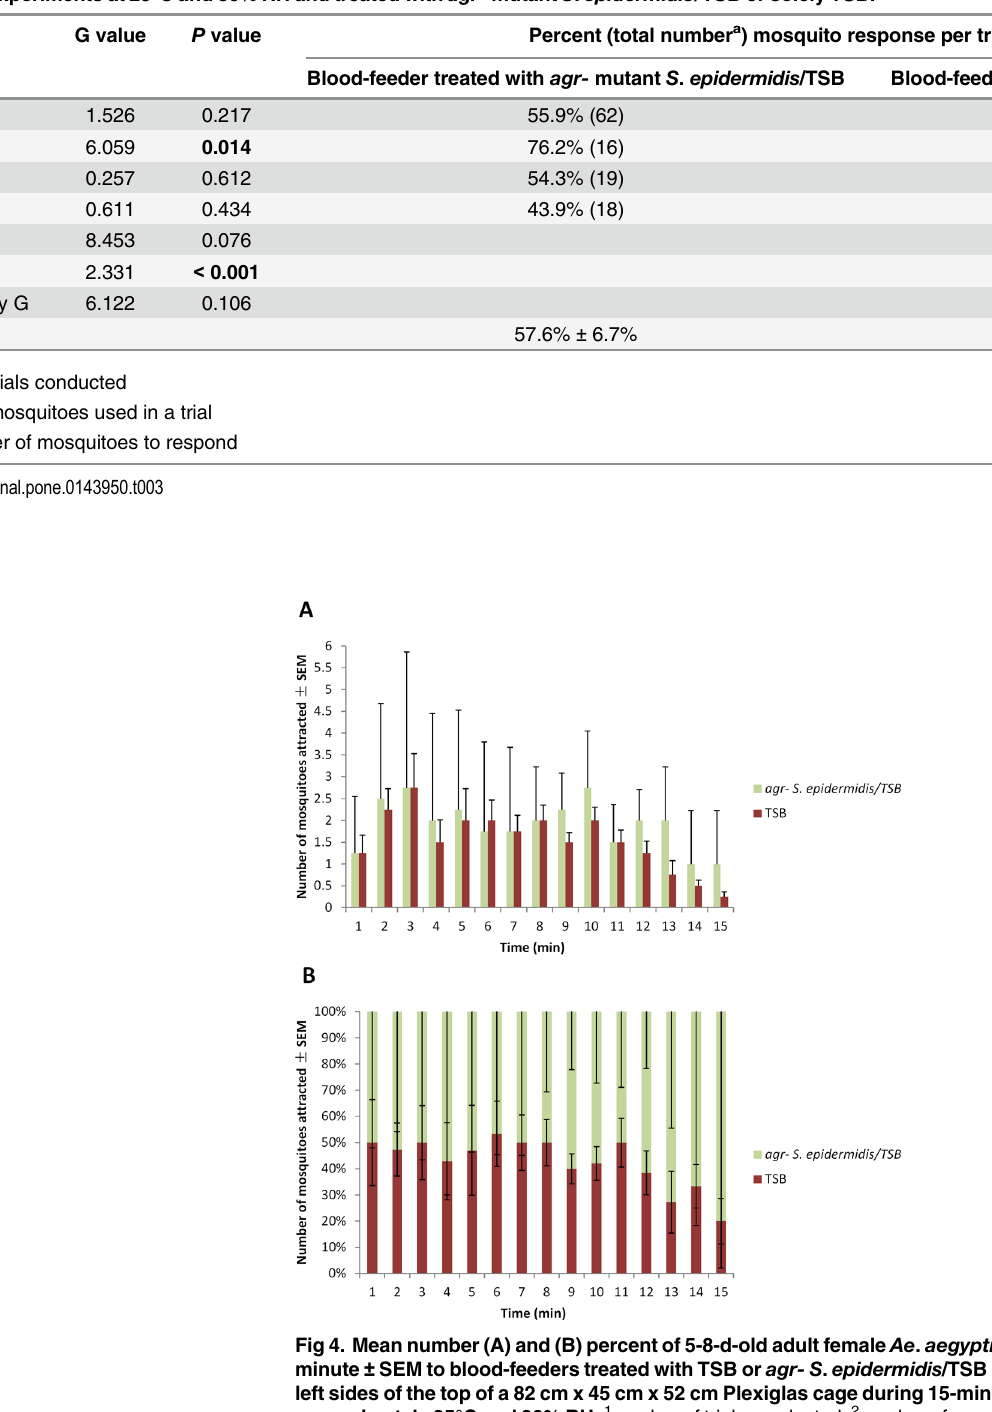
Table 3. Repeated G test of goodness-of-fit test, percent response per trial, and mean percent ± SEM across trials of the response of 5-8-d old Ae . aegypti (N 1 = 4; n 2 = 50) adult female attraction to blood-feeders located on opposite sides of the top of a 82 cm x 45 cm x 52 cm Plexiglas cage dur- ing 15-min experiments at 25°C and 80% RH and treated with agr- mutant S . epidermidis/ TSB or solely TSB.